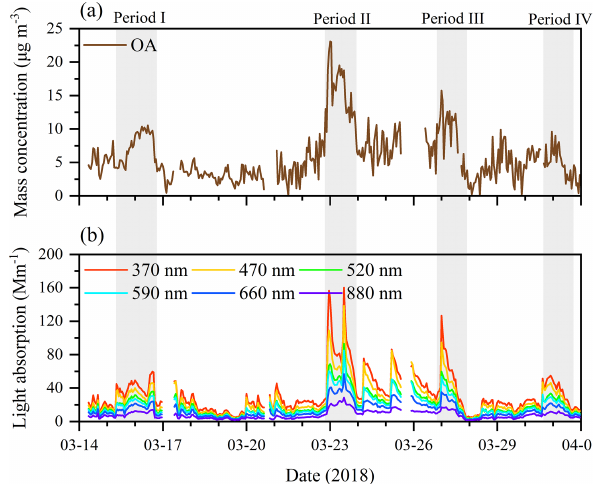
Figure 2. Hourly variations in (a) OA mass concentrations and (b) submicron aerosol light absorption coefficients ( b abs ) at differ- ent wavelengths (370, 470, 520, 590, 660, and 880nm) at Gaomeigu from 14 to 31 March